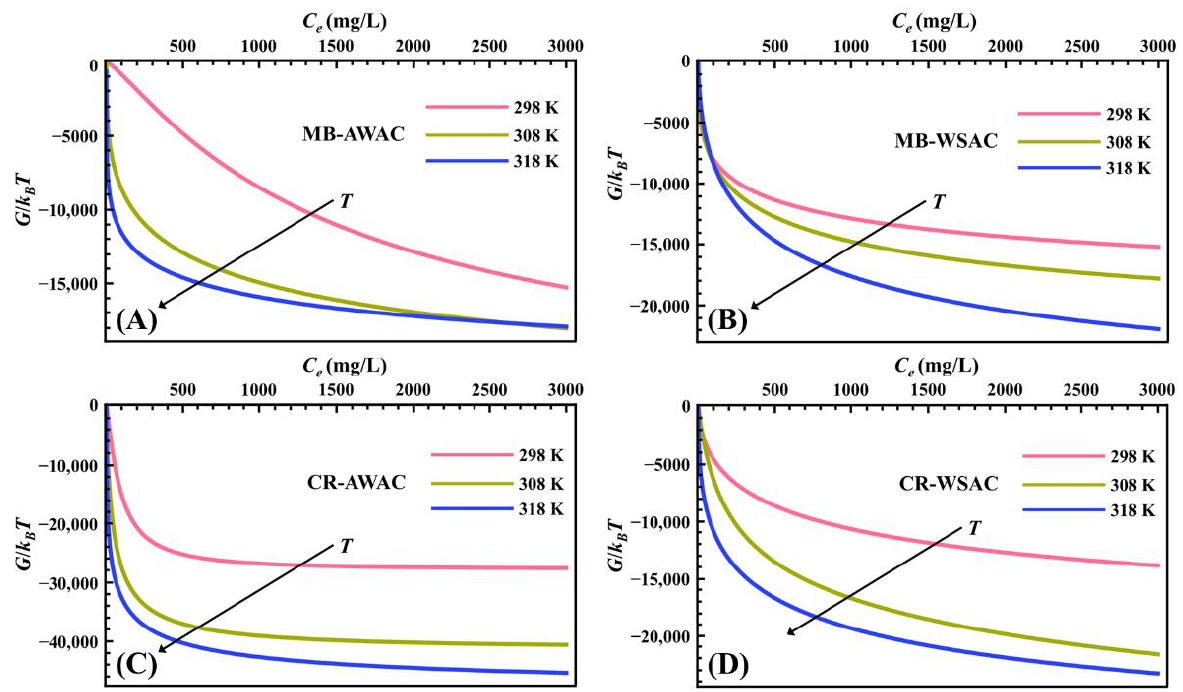
Figure 3. Gibbs free energy ( G ) evolution with dye concentration for MB-AWAC ( A ), MB-WSAC ( B ), CR-AWAC ( C ), and CR-WSAC ( D ) adsorption systems.